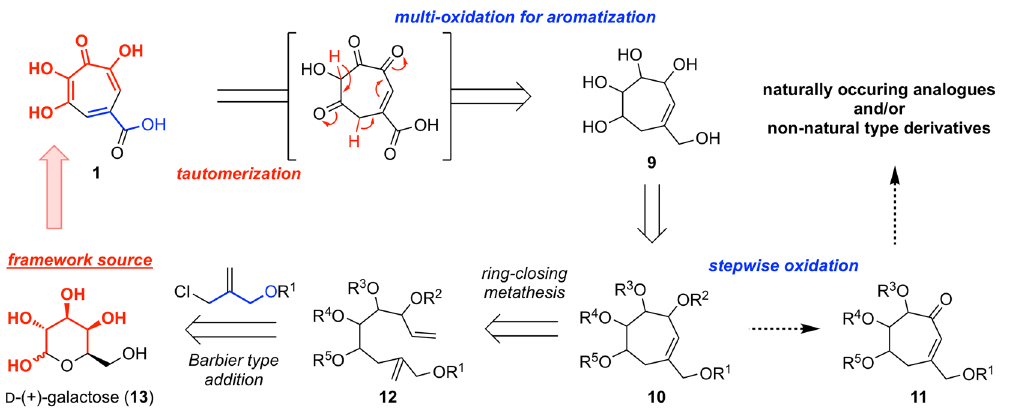
Figure 2. Synthetic strategy for divergent assembly of puberulic